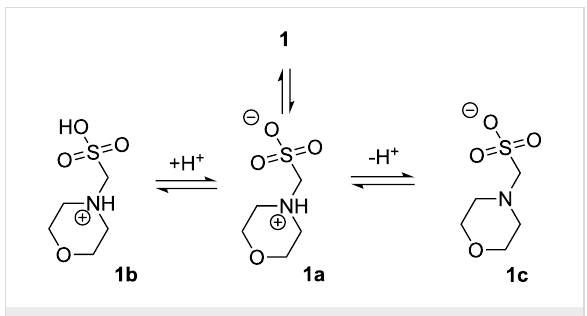
Figure 3: Possible ionization states of 1